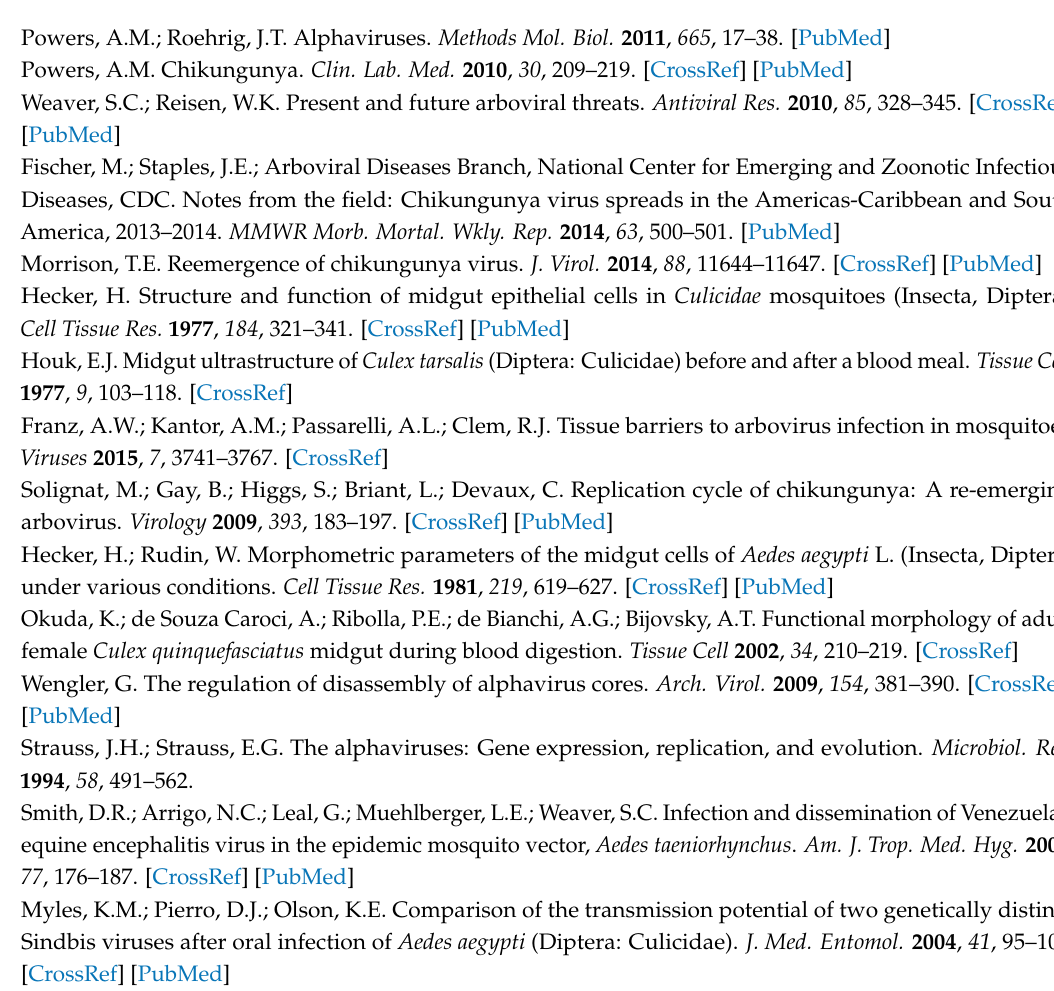
s1, Figure S1: Ultrastructural (SEM) imaging of the midgut surface of sugarfed and bloodfed (CHIKV-infected) Ae. aegypti , Figure S2: Higher magnification of ultrastructural (TEM) images showing midgut cross-sections obtained from female Ae. aegypti , Figure S3: Rare events observed during the ultrastructural TEM time course study, Table S1: Oligonucleotide primers used for Taqman qRT-PCR to detect CHIKV and MAYV cDNAs, Table S2: Sizes and volumes of midguts obtained from sugarfed and bloodfed Ae. aegypti